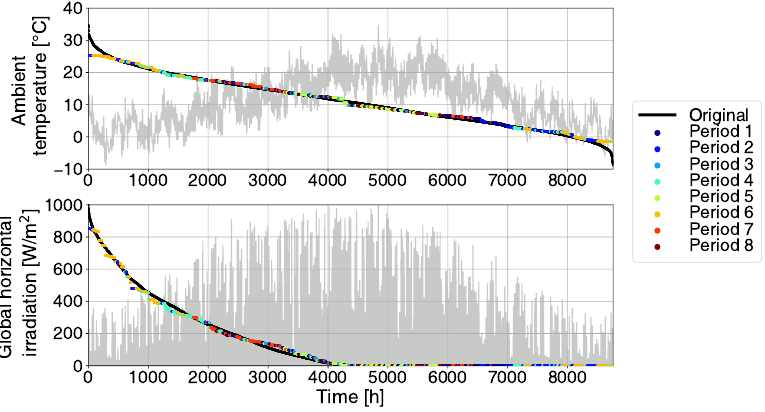
Figure 11. Representation of the typical days